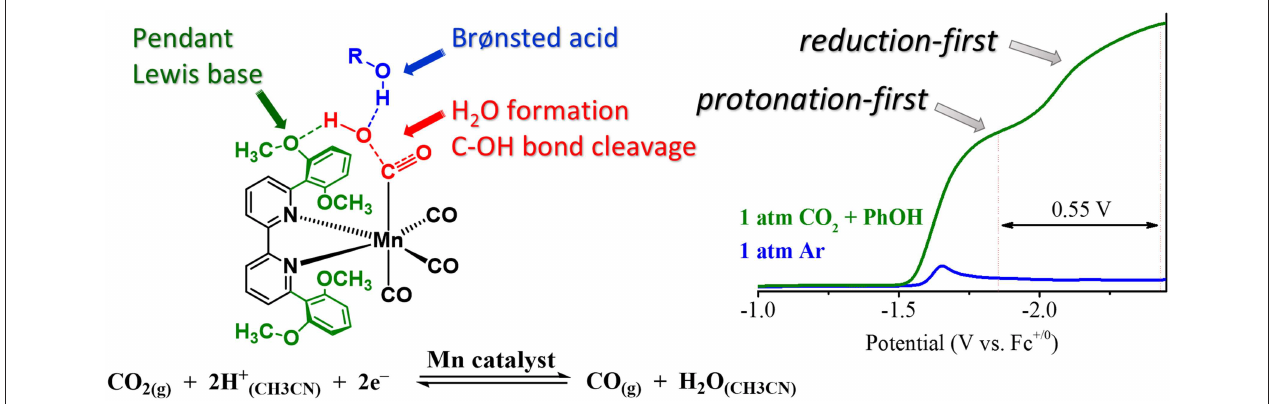
FIGURE 11 | Figure showing proposed transition state which occurs to turn on a low-overpotential, secondary-sphere-promoted mechanism for CO 2 reduction with Mn((OMe) 2 bpy)(CO) 3 X. Adapted with permission from Ngo et al. (2017). Copyright American Chemical Society 2017.